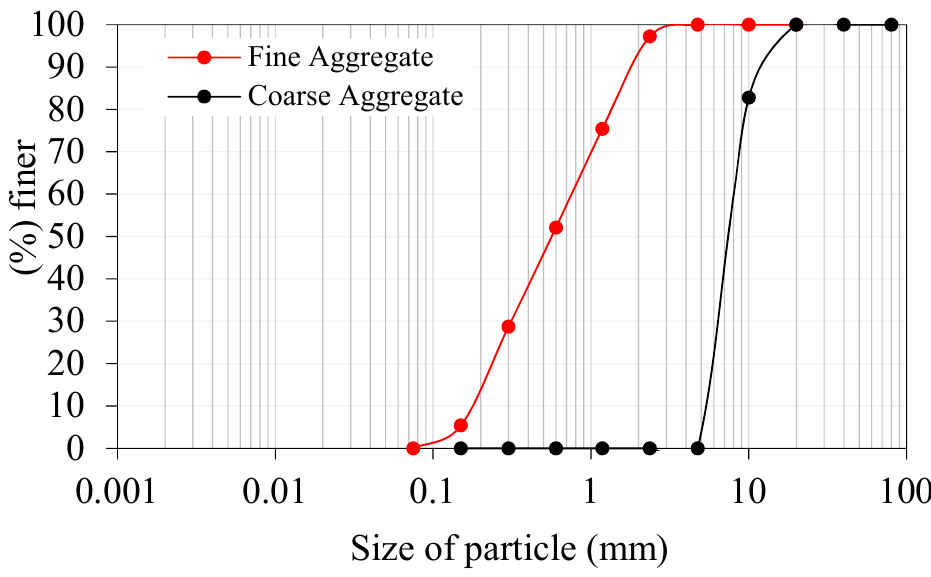
Figure 4. Gradiometric curve for the used aggregates.